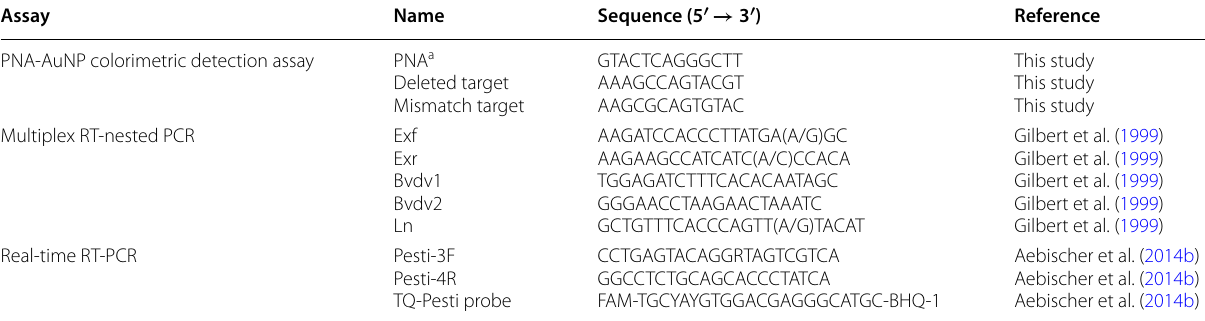
Table 1 PNA probe, primers, and target sequences used in PNA-AuNP colorimetric detection assay, multiplex RT-nPCR, and Real-time